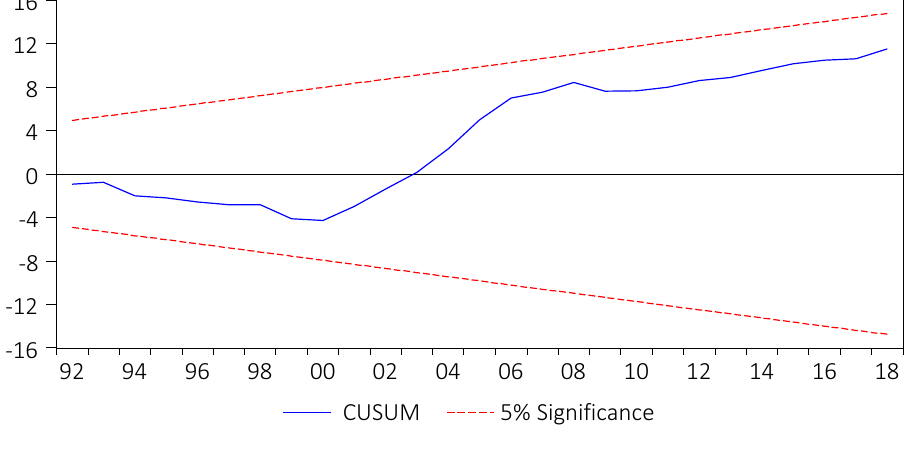
Figure 2. Cumulative sum (CUSUM)